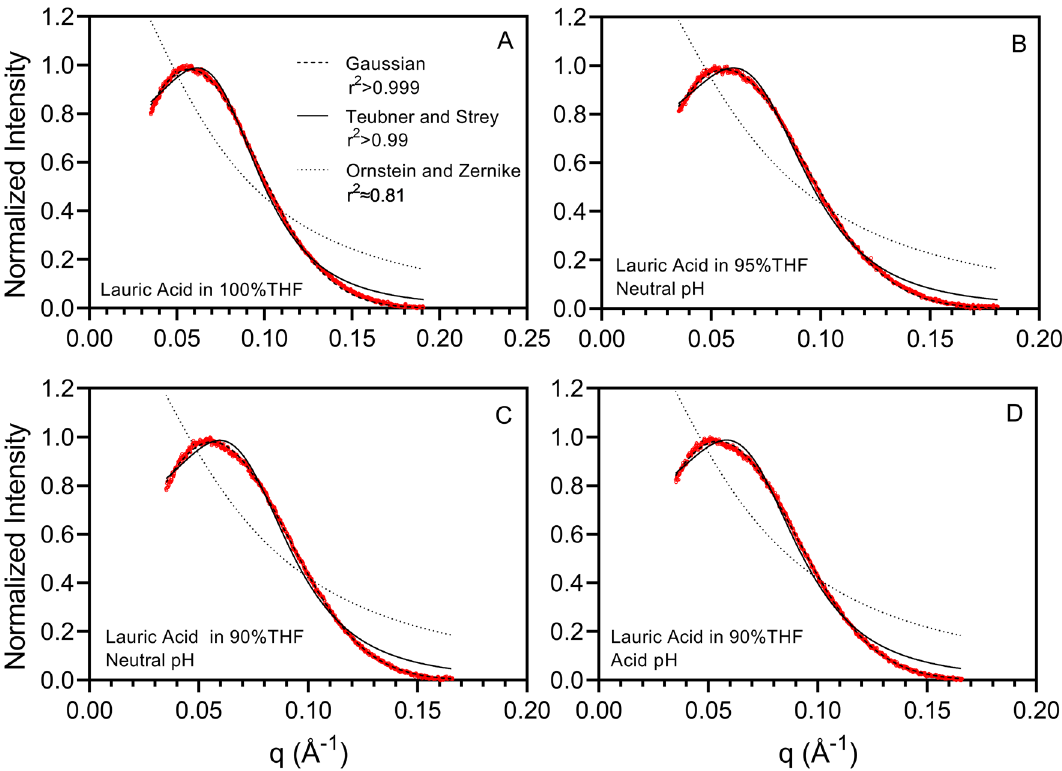
Figure 3. SAXS patterns of lauric acid in either 100% THF, or in THF-water mixtures, with 95% THF or 90% THF (at either acidic or circum-neutral pH) relative to water (v/v) and 500 g/L lauric acid. The experimental data are shown in red, and fit to the Steubner and Strey model (continuous black line) or a Gaussian (dashed line). The Ornstein and Zernicke fit (dotted line) is poor, and shown as a reference. The best fitting parameters of the Ornstein and Zernicke model are as follows: 100% THF: a 2 = 0.6572, c 1 = 152.8; 95% THF, neutral pH: a